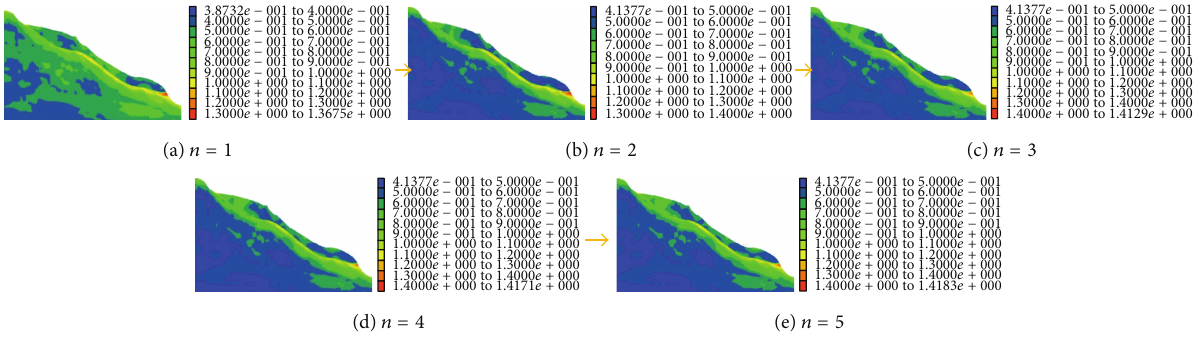
Figure 16: Velocity amplitude nephogram of the